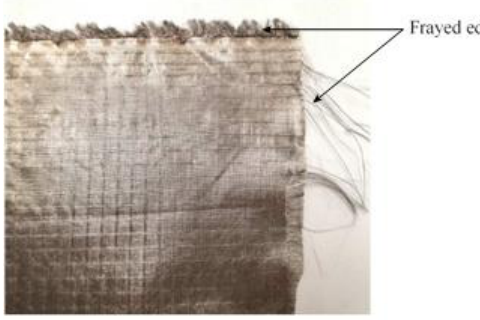
Figure 4. Fraying in the edge of the fabrics.